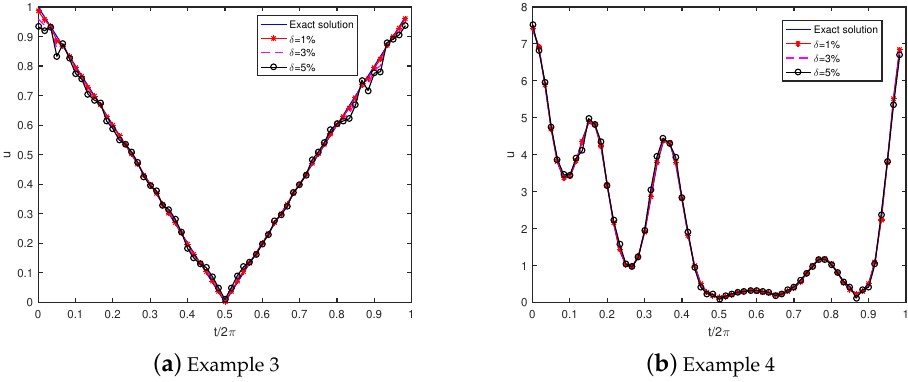
Figure 4. The numerical solutions with the percentages of noise increasing from 1% to 5% on ∂ D .